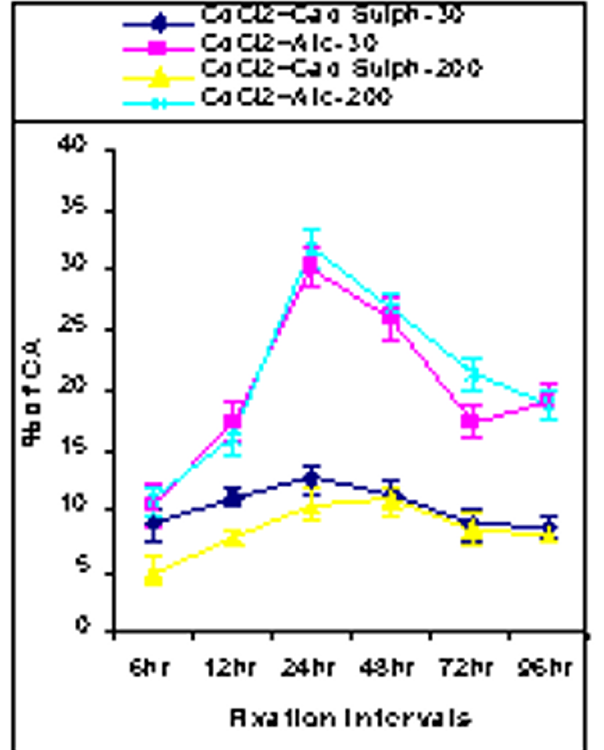
Figure 11 Showing time-dependent frequencies of Cad Sulph-30 com- bined pre- and post-fed and Cad Sulph-200 combined pre- and post-fed series versus their respective CdCl 2 treated alcohol-30 and alcohol-200 control mice. Chromosome aberration (CA)-9; Mitotic index (MI)-10; Micronucleated erythrocytes (MNE)-11 and Sperm head anomaly